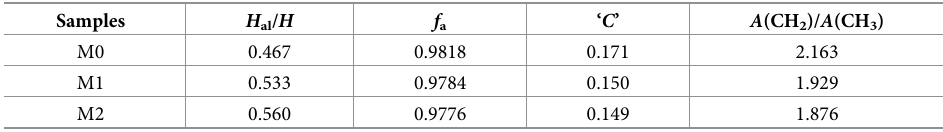
Table 6. Infrared structural characteristic parameters of coal